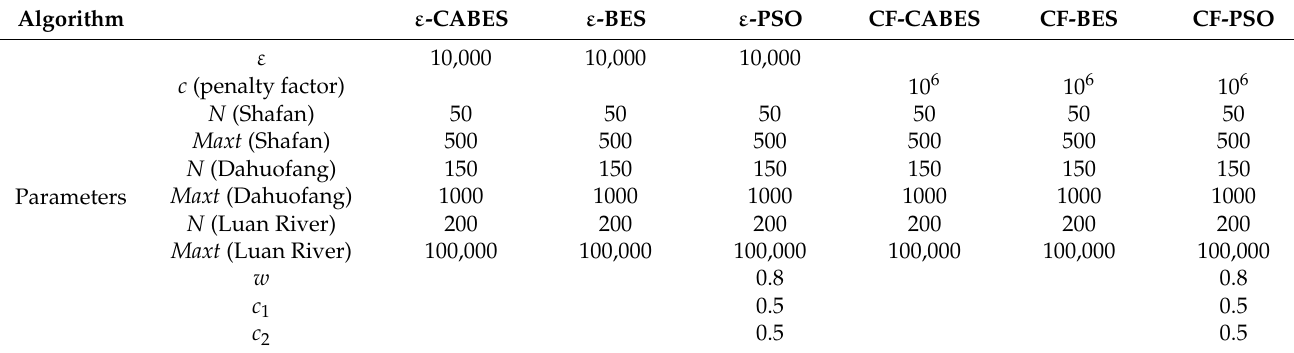
Table 4. Parameter settings of different